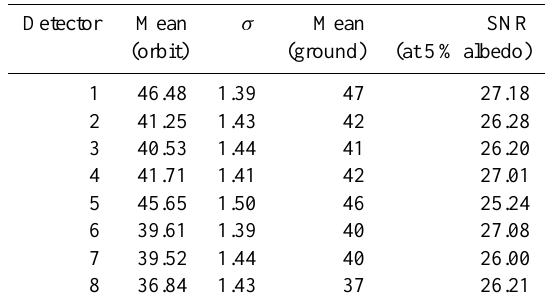
Table 2. The mean and standard deviation ( σ) of space look count and the derived signal-to-noise ratio (SNR) at 5% albedo (reference user requirement for SNR of 10 is given at 5%